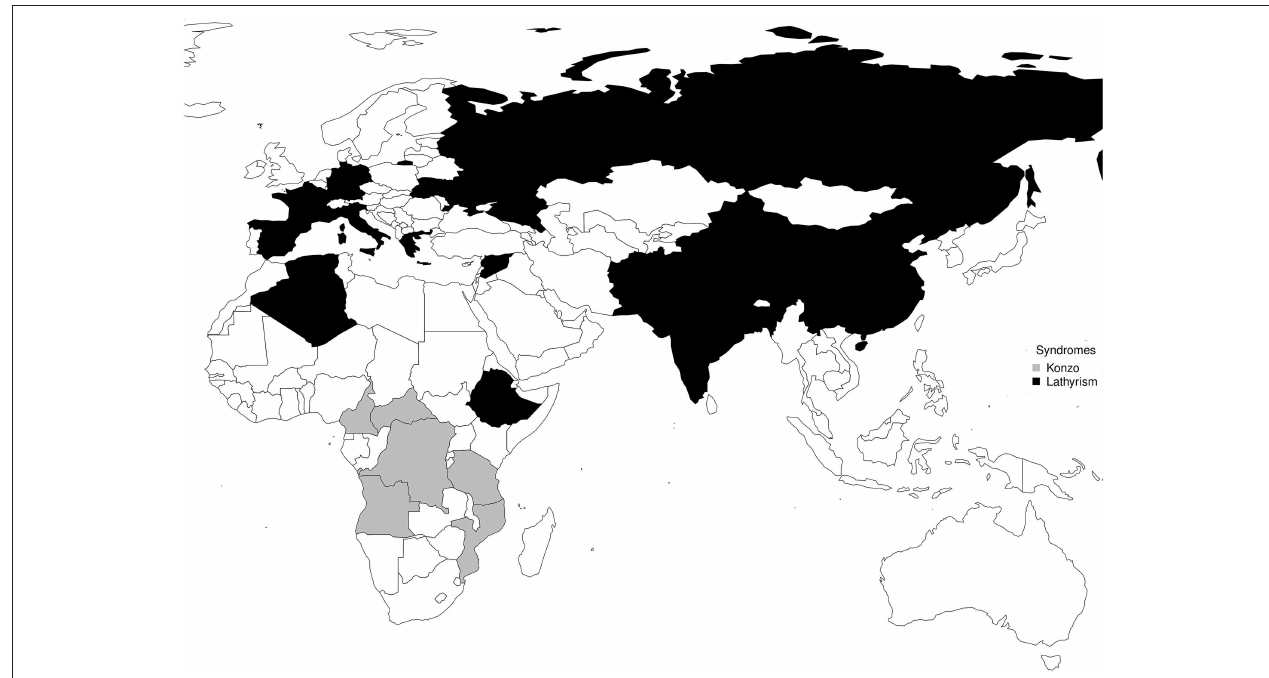
FIGURE 7 | Geospatial distribution of lathyrism and konzo.